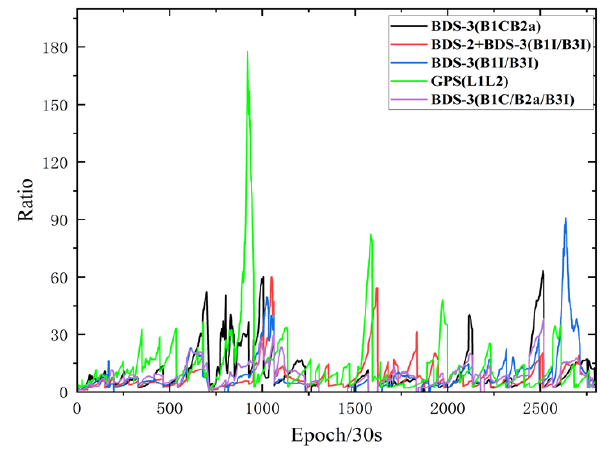
Figure 10. Ratio value variation of TGCU-TGDA (96 km).